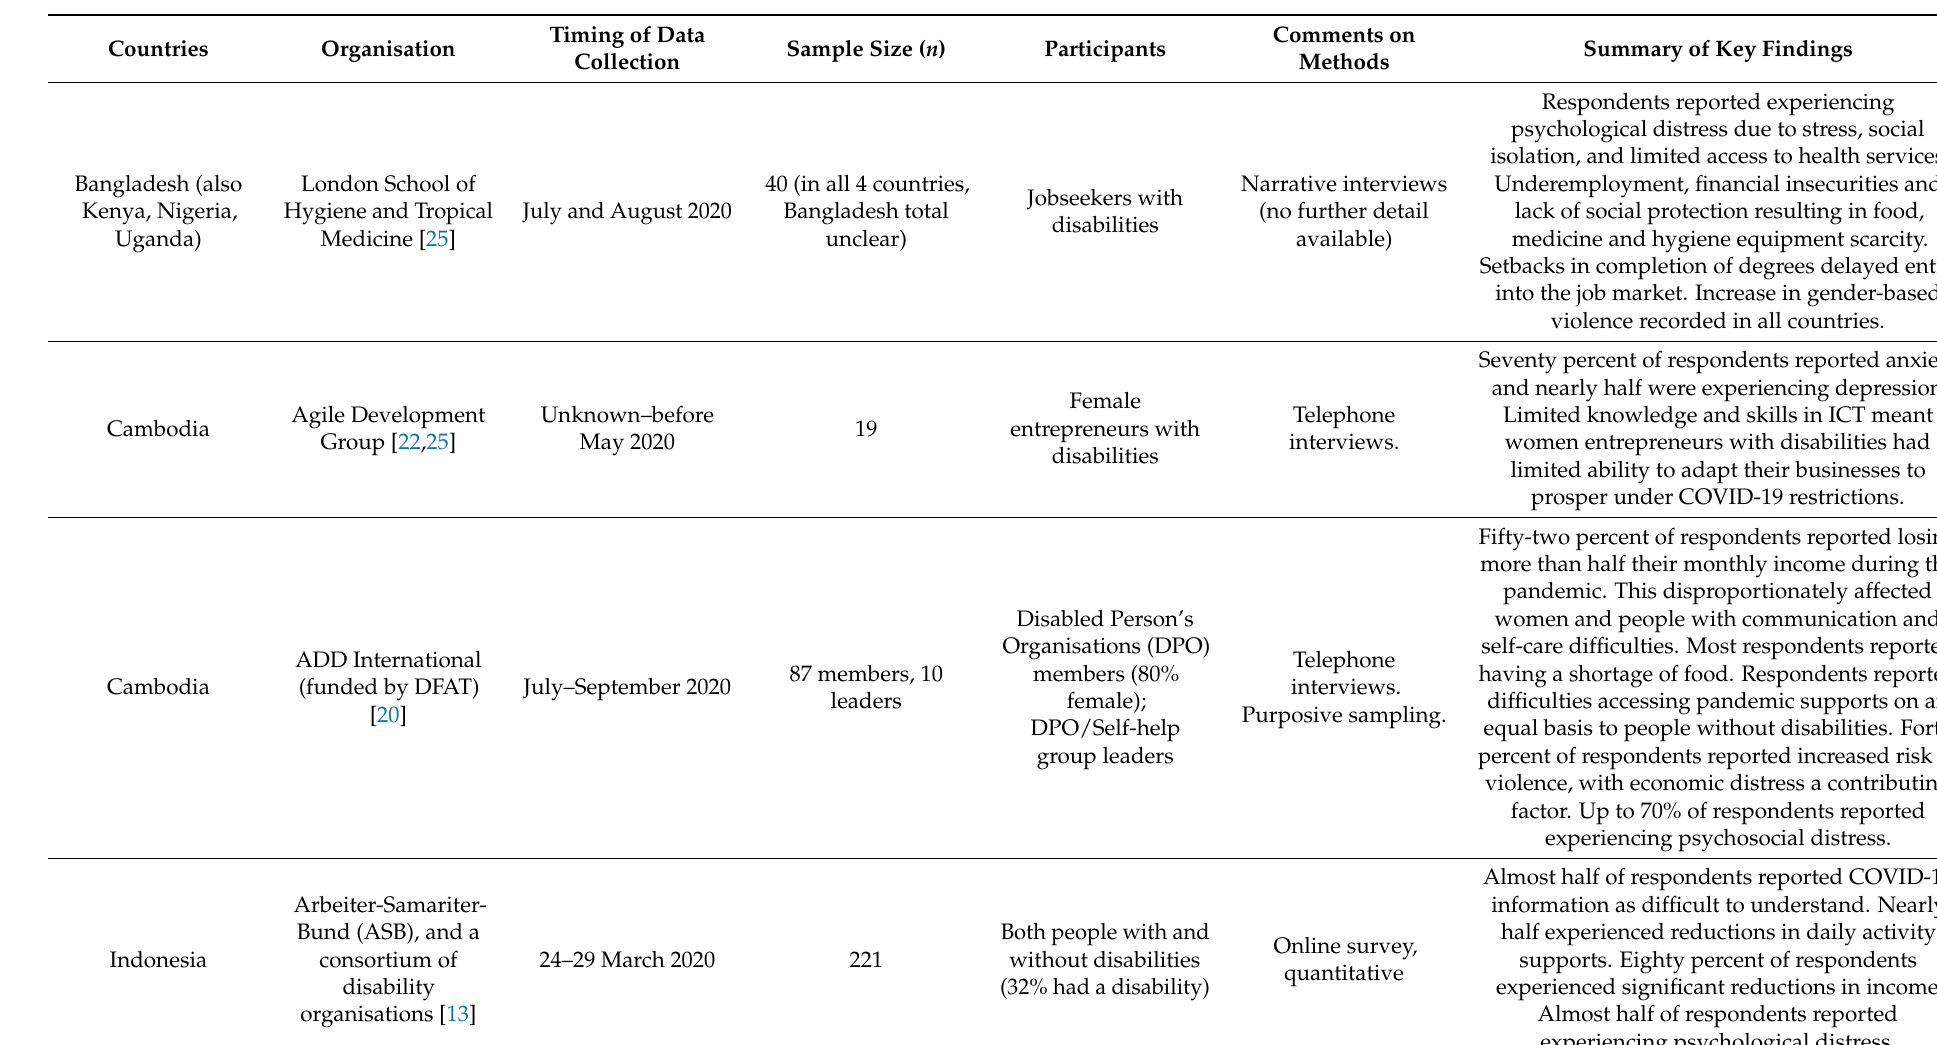
Table 1. Studies of disability and COVID-19 included in the evidence